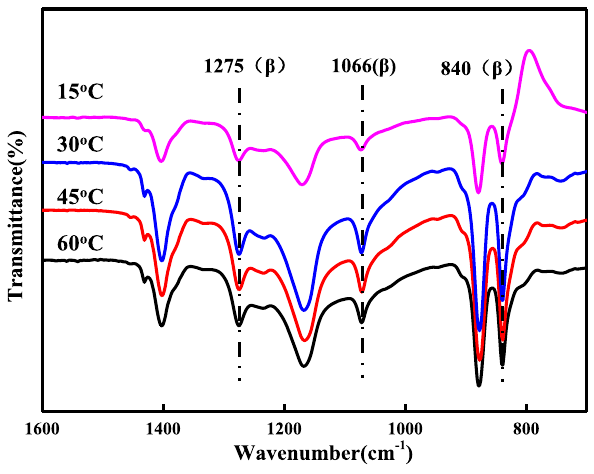
Fig. 4 FTIR spectra of PVDF membranes produced with different quenching